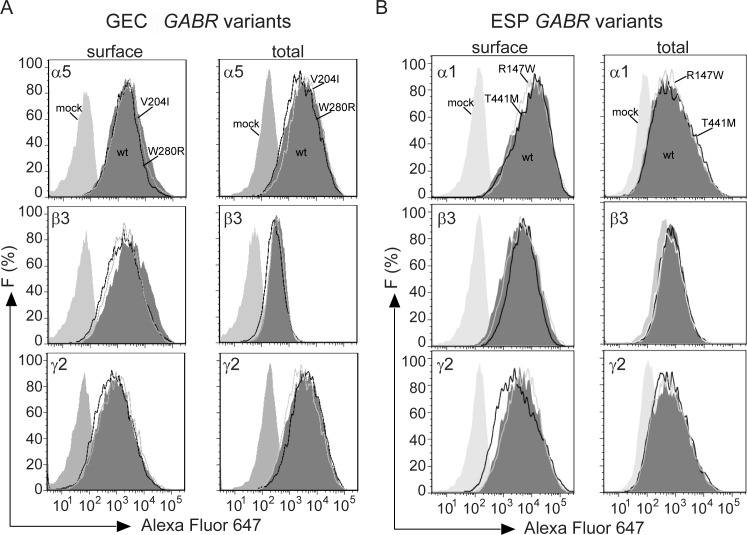
Deleterious GABR variants did not reduce surface and total levels of GABAA receptor subunits.(A), Fluorescence intensity (F) of representative surface and total expression histograms of α5HA, β3, and γ2FLAG subunits for wild type (wt) and α5β3γ2 receptors containing α5HAV204I and α5HAW280R GEC variants. Grey areas under the histograms represent mock (light) and wild type subunits (dark) respectively, while solid lines represent α5HAV204I (grey) and α5HAW280R (black) subunits. (B), Fluorescence intensity (F) of representative surface and total expression histograms of α1, β3, and γ2HA subunits for wild type (wt) and α1β3γ2 receptors containing α1R147W and α1T441M ESP variants. Grey areas under the histograms represent mock (light) and wild type subunits (dark), respectively. Solid lines represent α1R147W (grey) and α1T441M (black) subunits.